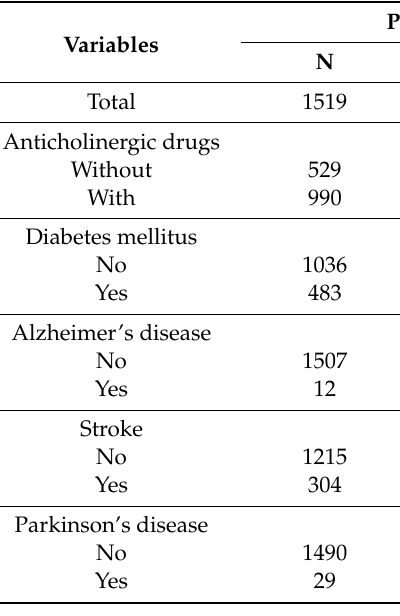
Table 3. The incidence rate of pneumonia in elderly